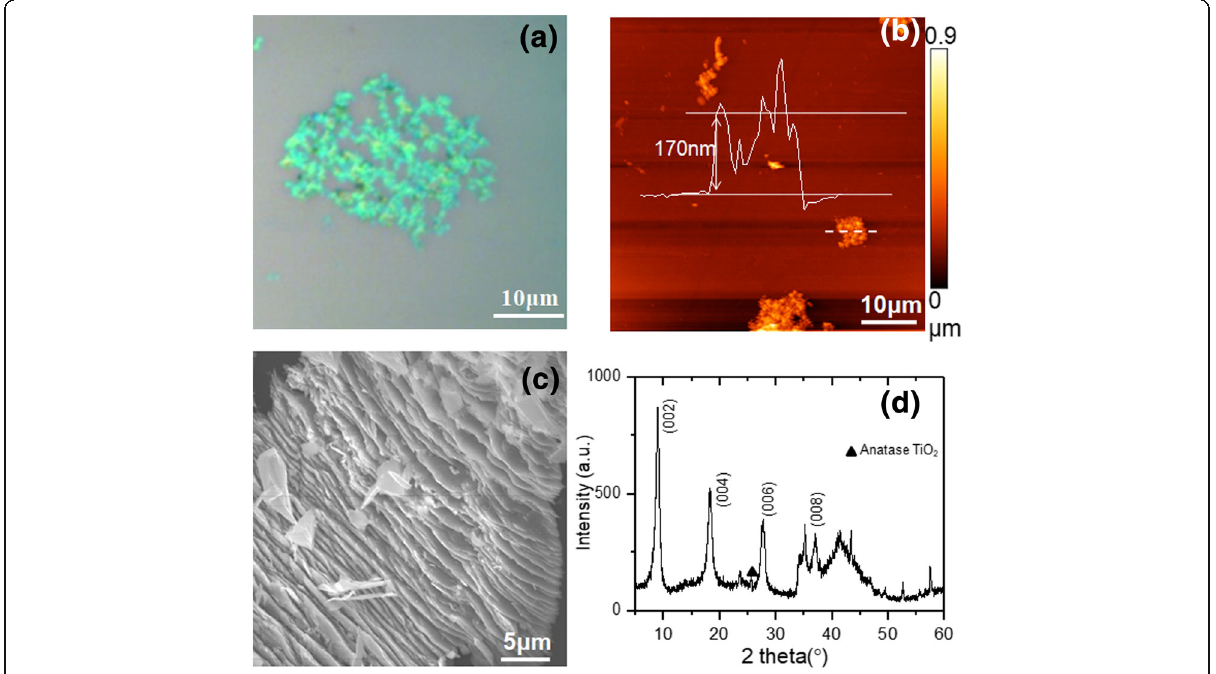
Fig. 1 a Optical image of ultrasonically exfoliated Ti 3 C 2 T x flakes; b AFM topographic image of ultrasonically exfoliated Ti 3 C 2 T x flakes, and a line profile across the marked dashed line is shown as an inset, indicating the Ti 3 C 2 T x flake thickness of 170 nm; c SEM image of ultrasonically exfoliated Ti 3 C 2 T x flakes; d XRD spectra of Ti 3 C 2 T x raw